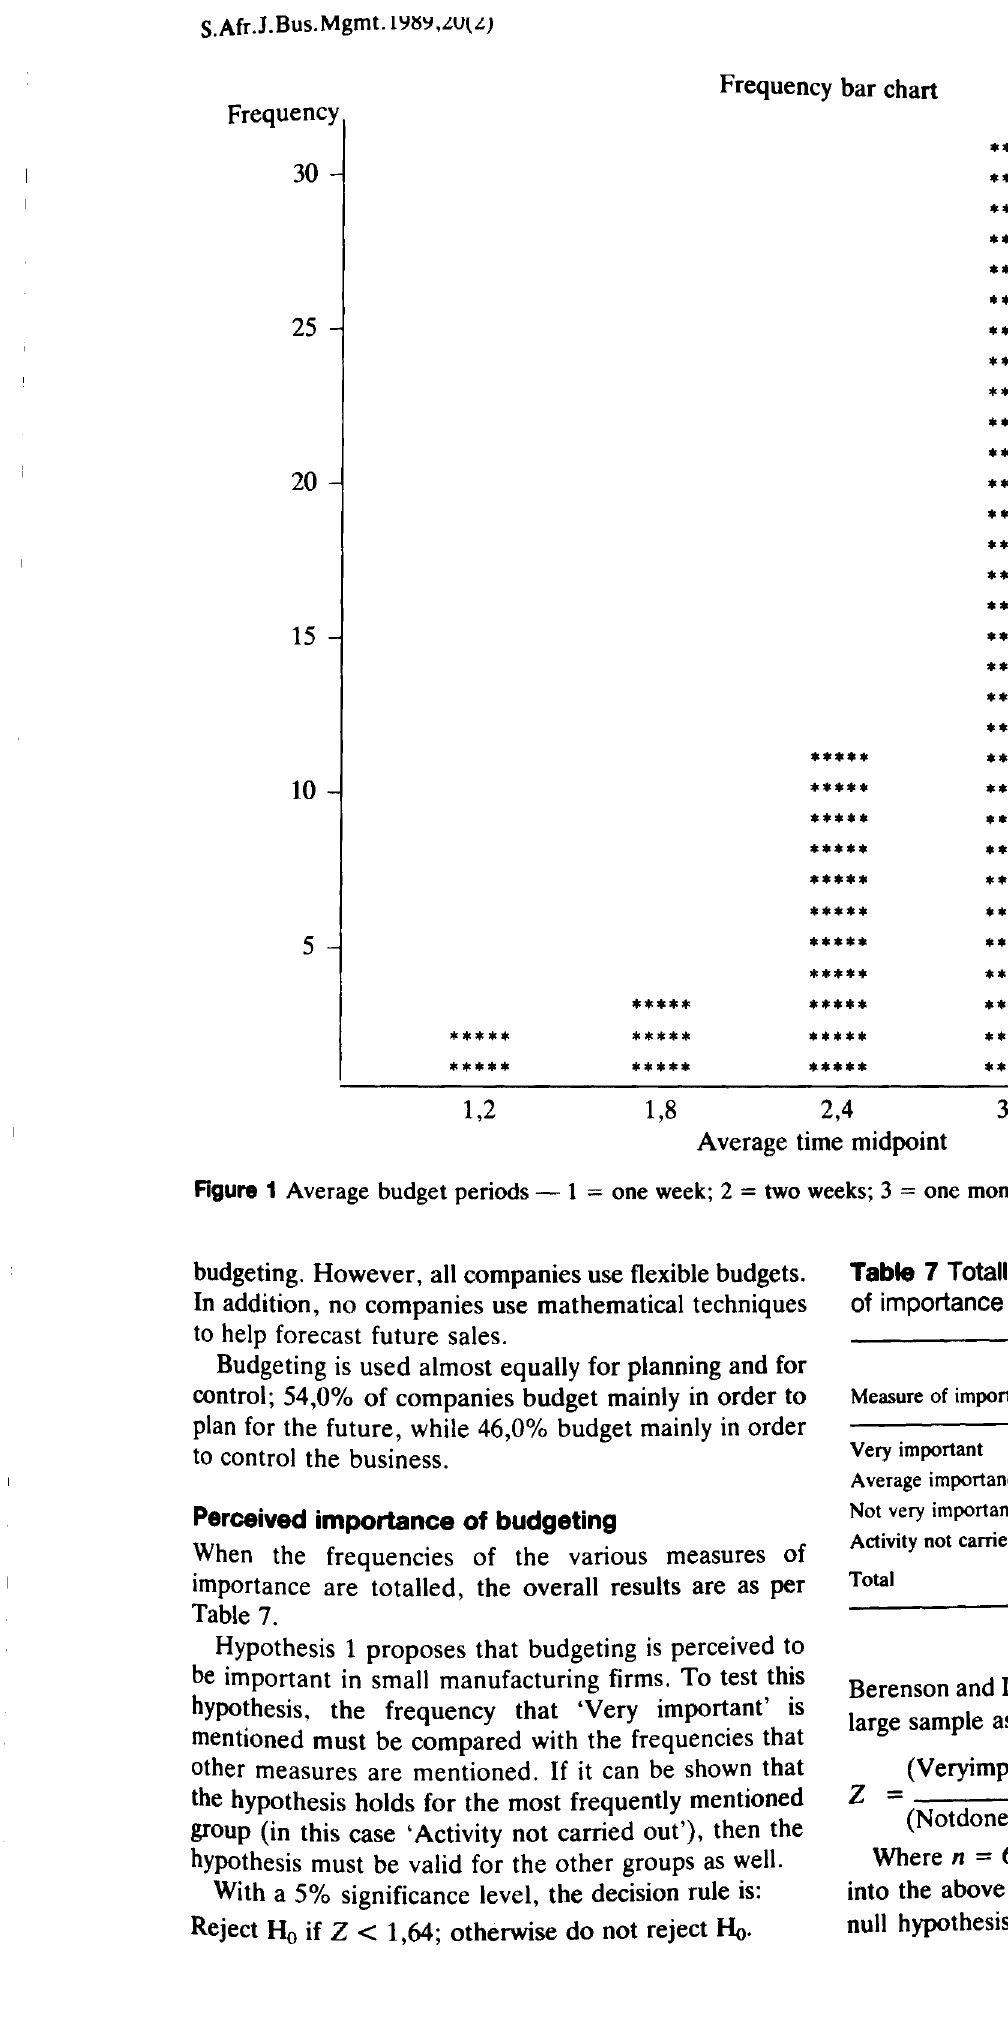
Figure 1 Average budget periods - 1 = one week; 2 = two weeks; 3 = one month; 4 = three months